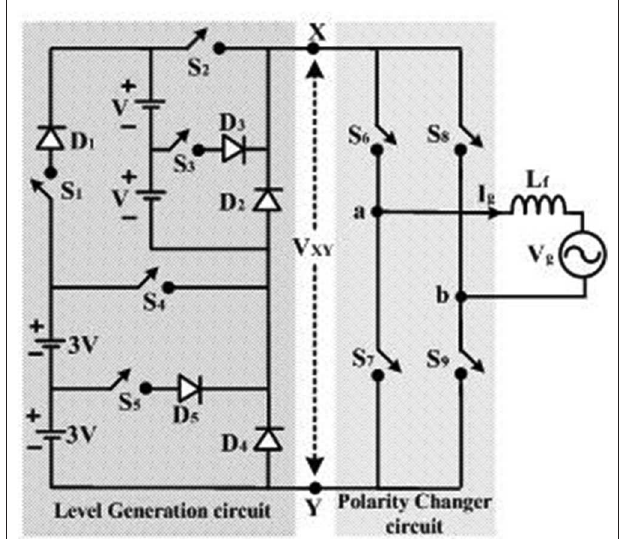
FIGURE 2 | Proposed configuration of seventeen level inverter